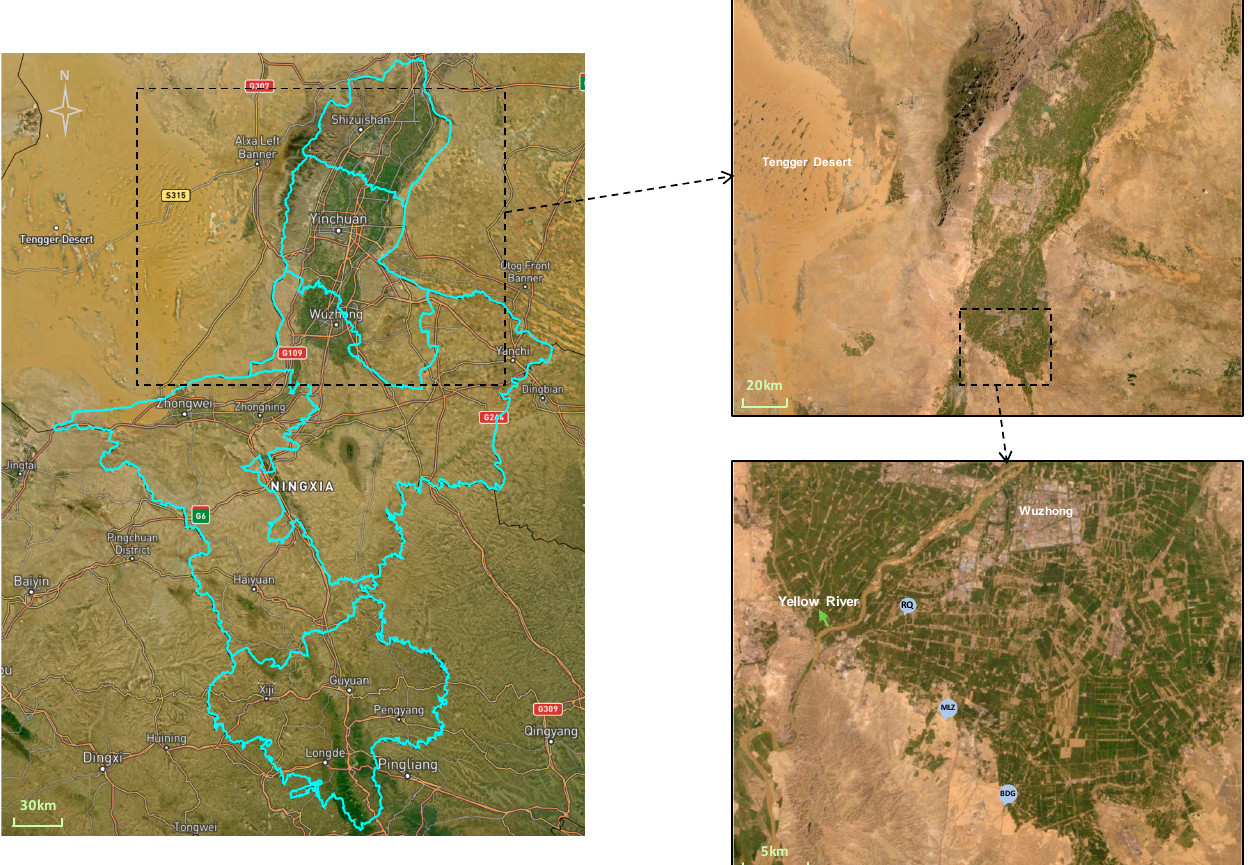
Figure 1. Sites distribution of the field trial near the Tengger Desert in Ningxia. RQ, Renqiao village (silty clay loam soil); MLZ, Miaolaingzi village (desertified land, sandy clay loam soil); BDG, Biandangou village (desertified land, sandy clay loam soil).